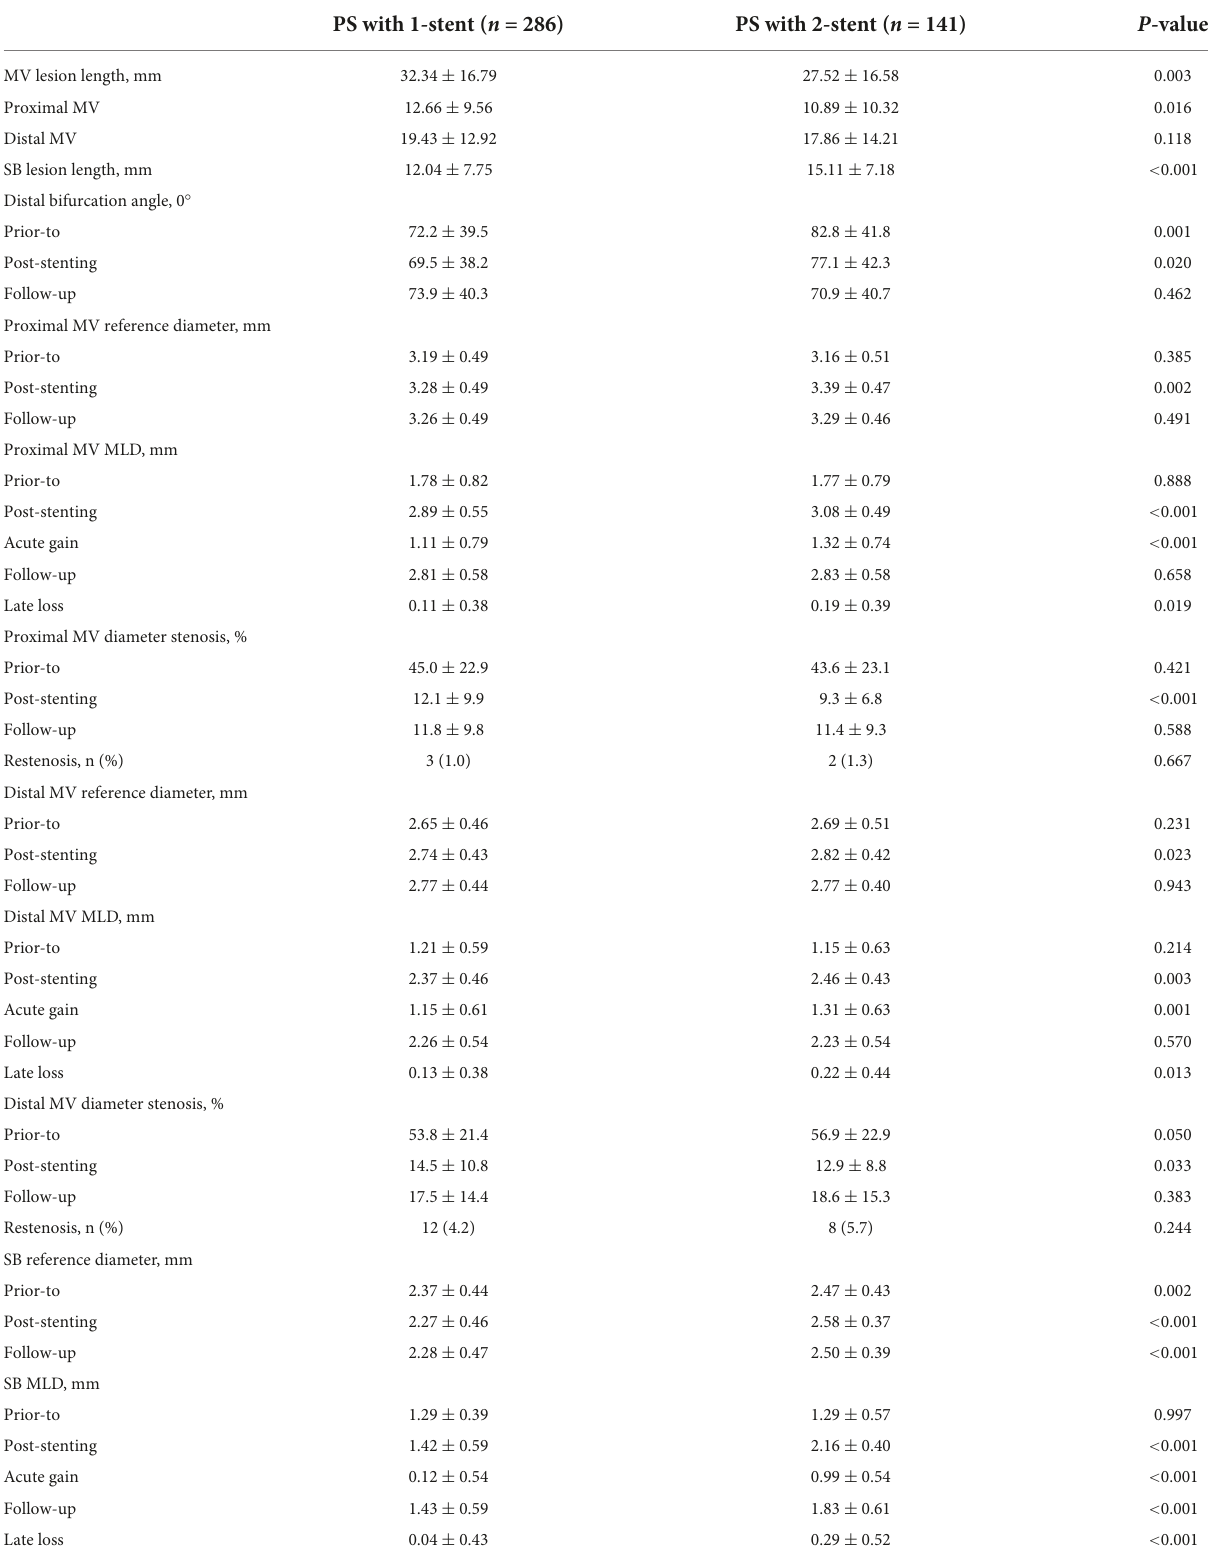
TABLE 3 Quantitative angiographic